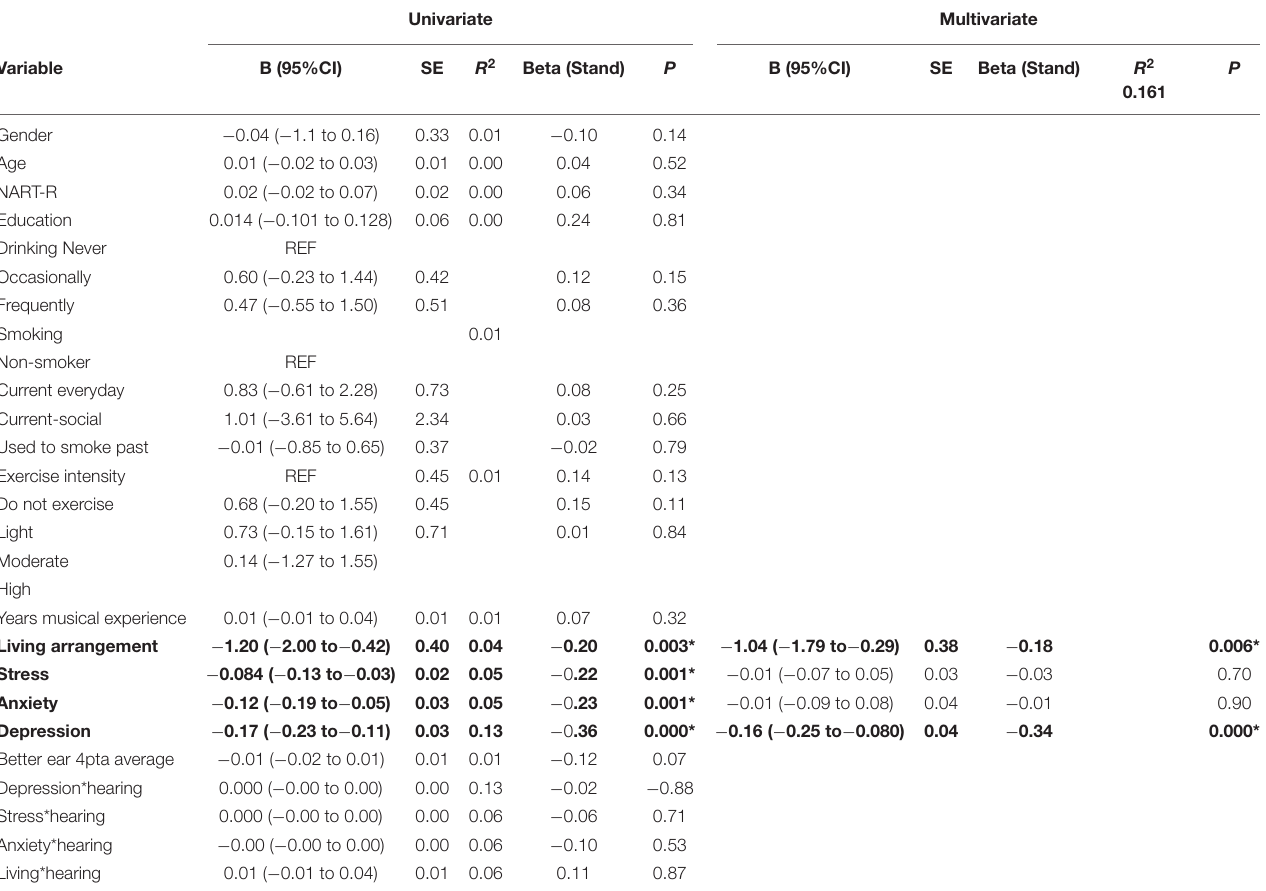
TABLE 3 | Univariate and multivariate analysis, satisfaction with social support received (SS).